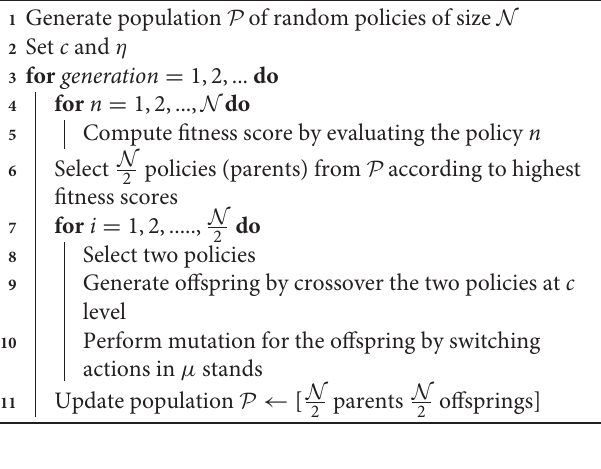
Algorithm 3: Off-Policy Actor-Critic with